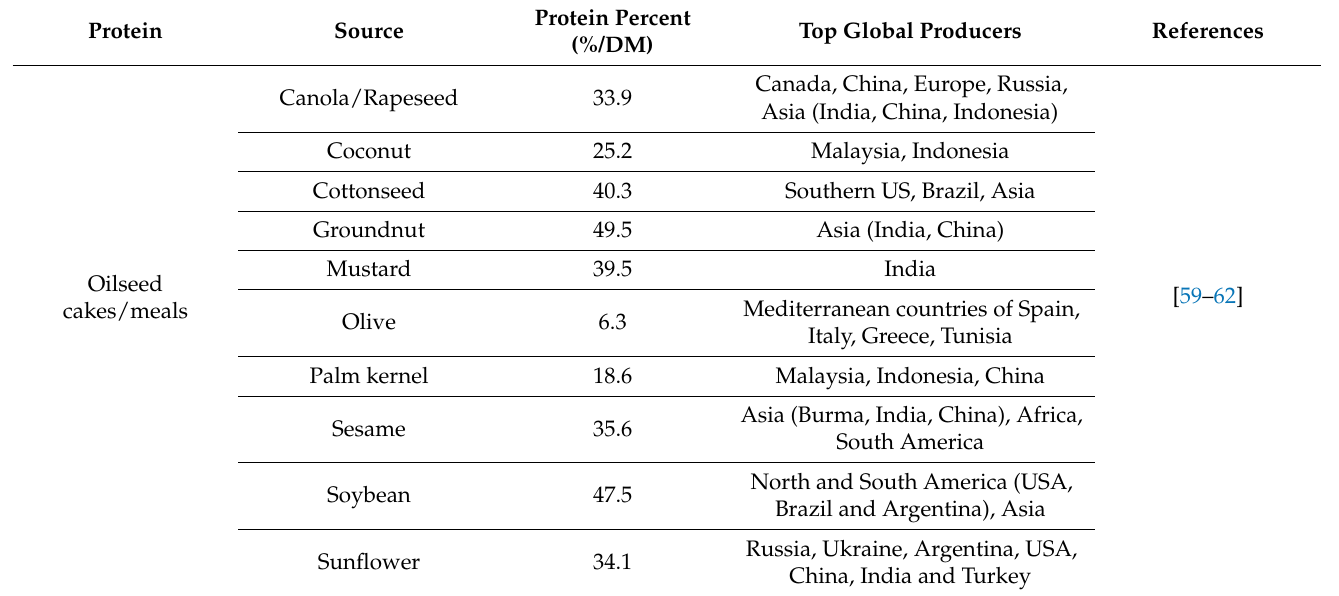
Table 1. Rich protein sources and their global producers. Rich sources of crude protein composition (percent/dry matter